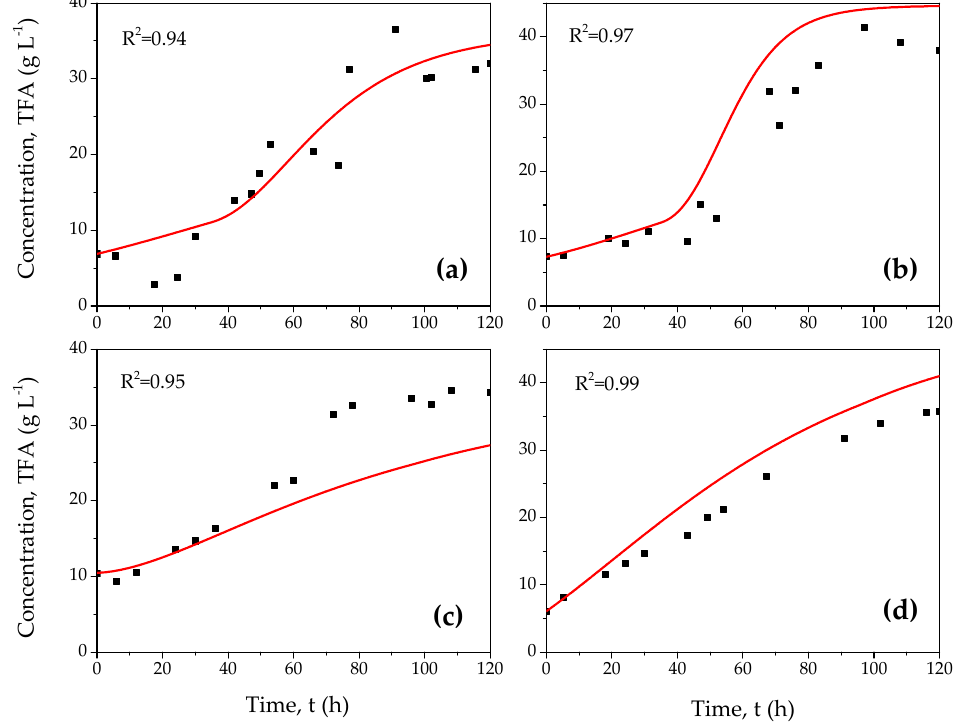
Figure 5. Dynamical of VFA including pH and temperature functions at different operation conditions. ( a ) pH = 5.5, T = 35 °C; ( b ) pH = 5.5, T = 40 °C; ( c ) pH = 7.5, T = 35 °C; ( d ) pH = 7.5, T = 40 °C.